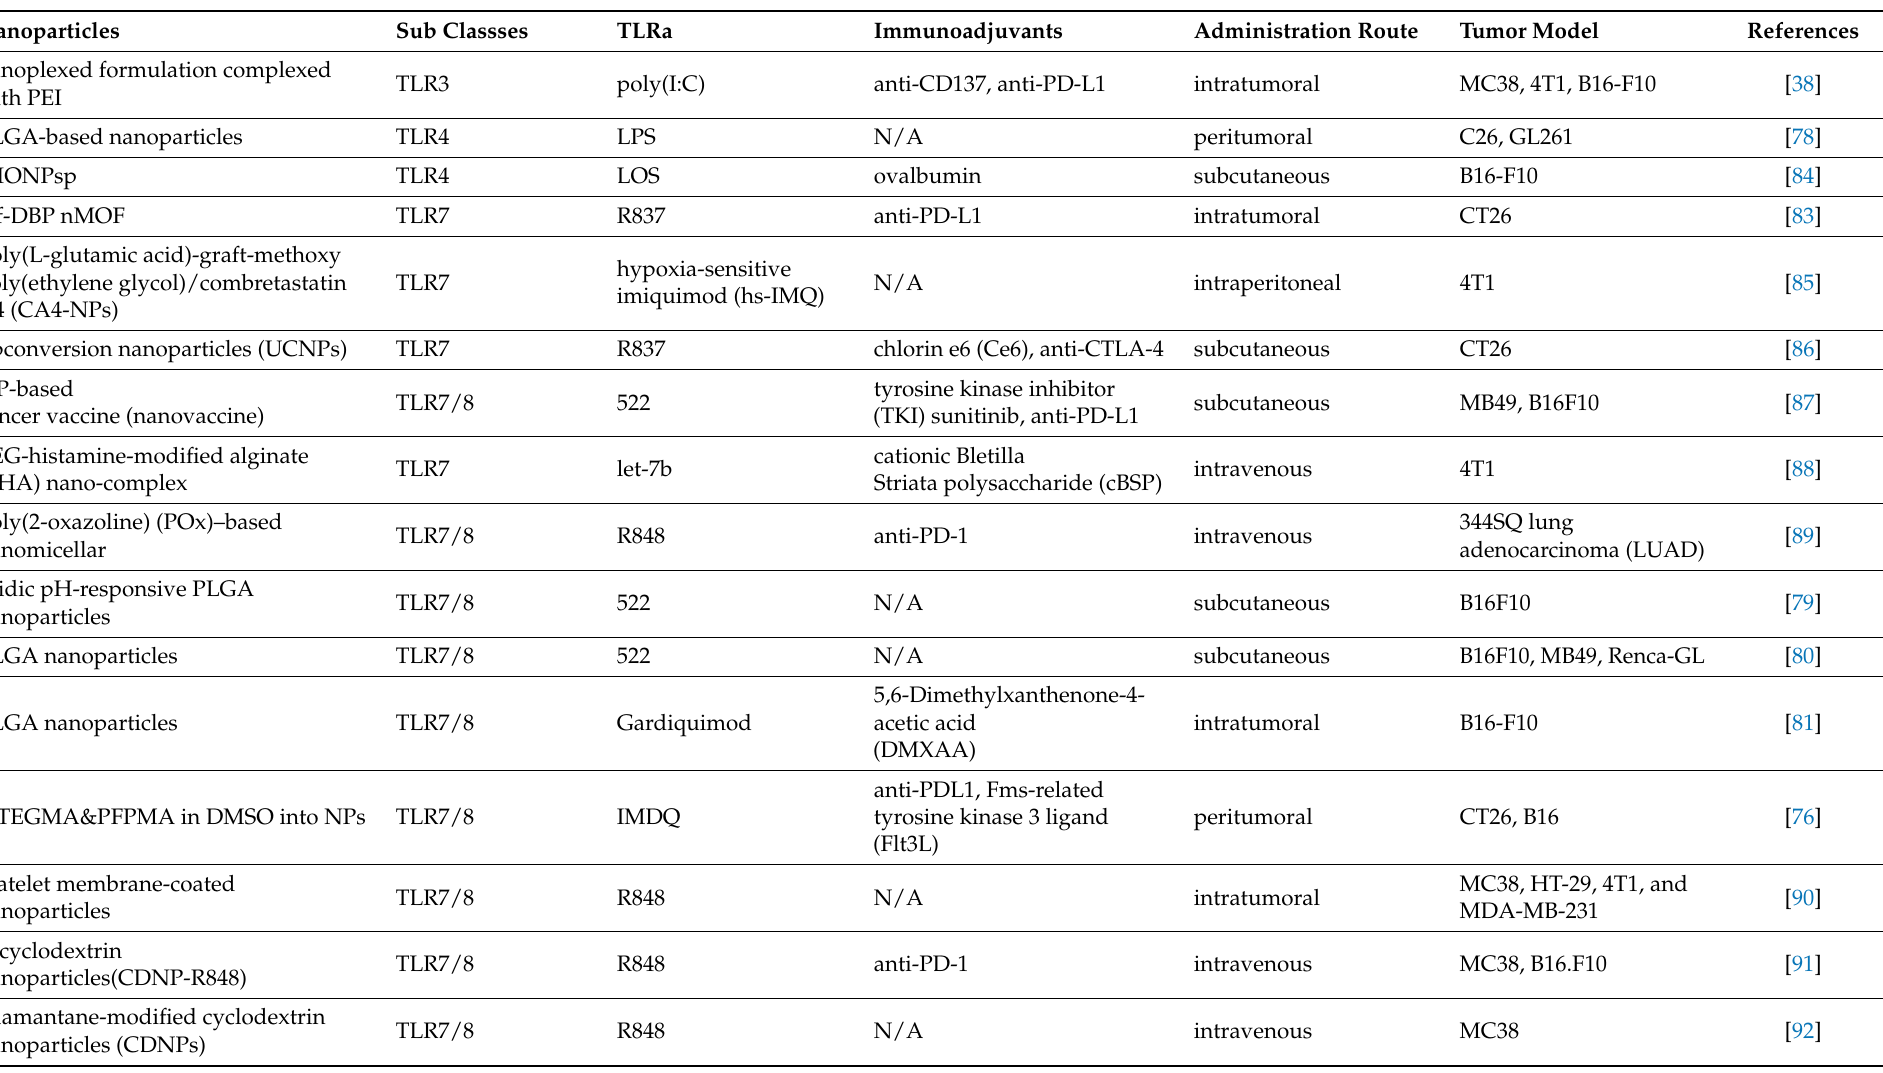
Table 1. A single TLRa in combination with